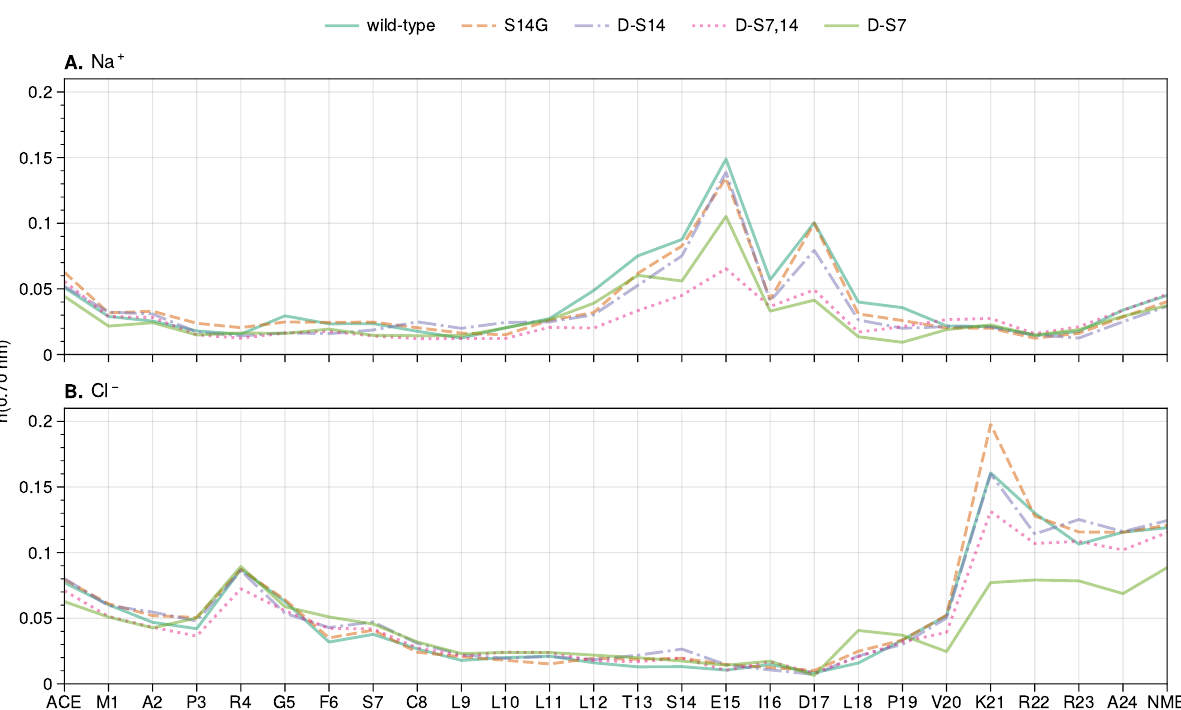
Figure 5. Sodium ( A ) and chloride ( B ) ion distribution along the residue index for wild-type and mutants of HN. Mean number of ions (running coordination number) is given as the integral of g ( r ) for the ion up to the second hydration shell ( r ≤